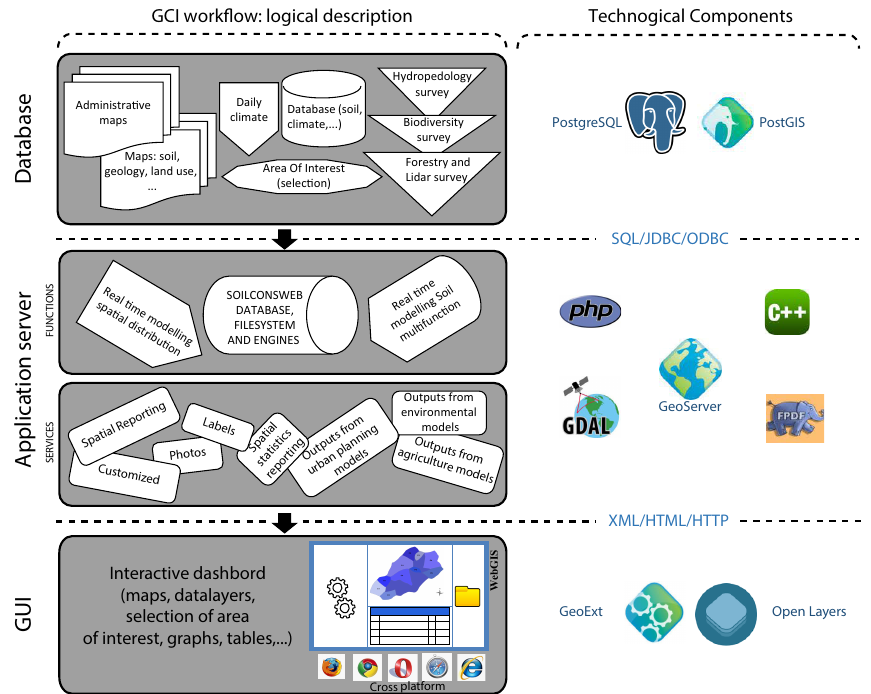
Figure 3. Simplified diagram describing SOILCONSWEB geospatial cyberinfrastructure architecture and its main technological compo- nents. Abbreviation: GUI – graphical user